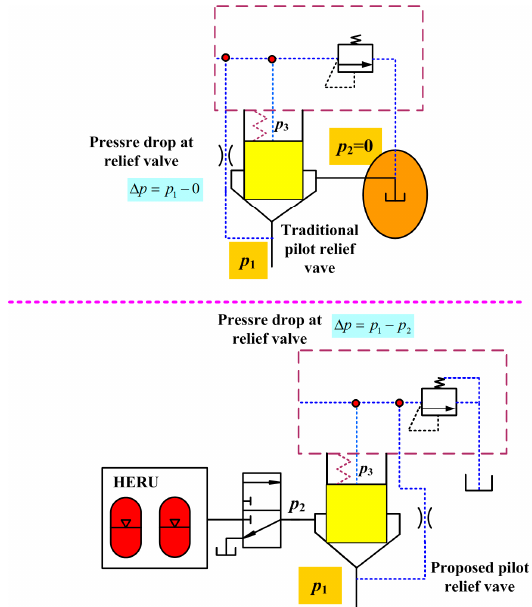
Figure 1. Comparison of the pilot relief valve (PRV) with and without hydraulic energy regeneration unit (HERU).